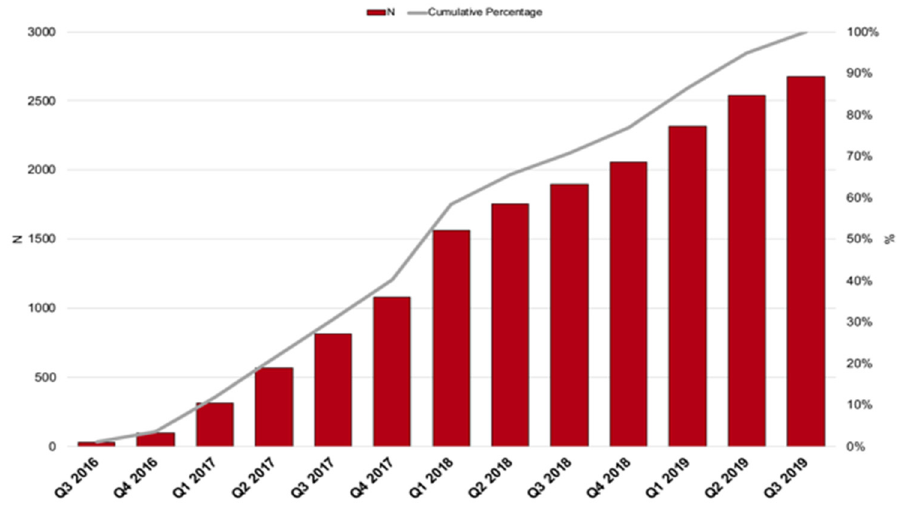
Figure 1. RI-AIAC registry enrolment rates.